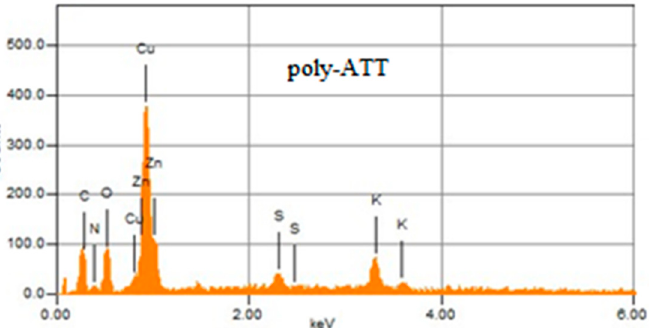
Figure 11. EDX spectrum obtained on the brass surface after synthesis of polymer film poly-ATT.